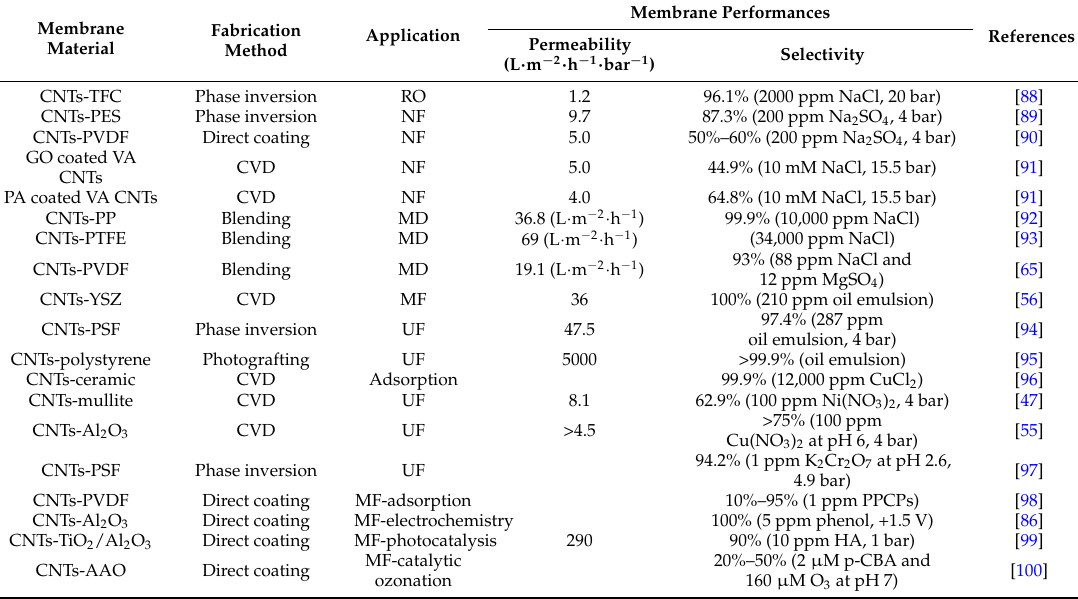
Table 4. An overview of fabrication, application and performances of the CNTs-based composite membranes.